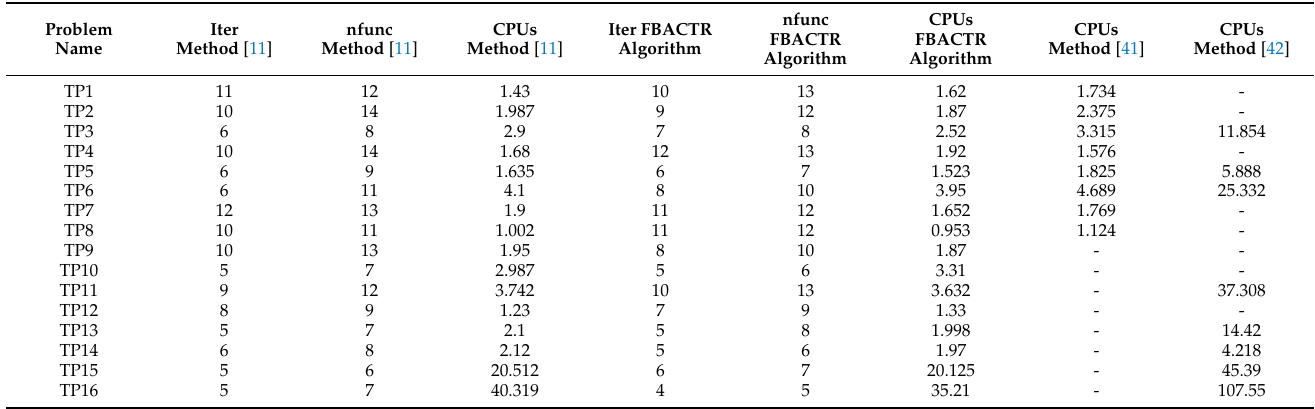
Table 2. Comparisons of the results of FBACTR Algorithm 5 with method [11], method [41] and method [42] with respect to the number of iterations, the number of function evaluations, and